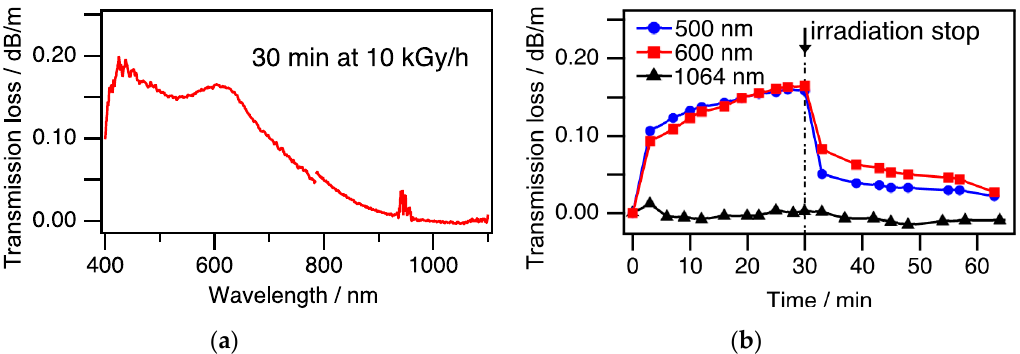
Figure 3. Transmission loss of the optical fiber induced by gamma irradiation (10 kGy/h). ( a ) Spectrum of transmission loss after 30 min irradiation. The fluctuations at around 950 nm originated from the inherently low transmittance of the high-OH fiber due to the strong photoabsorption of OH. ( b ) Time evolution of the transmission loss at 500 nm (blue circle), 600 nm (red square), and 1064 nm (black triangle). The gamma irradiation was stopped at 30 min.